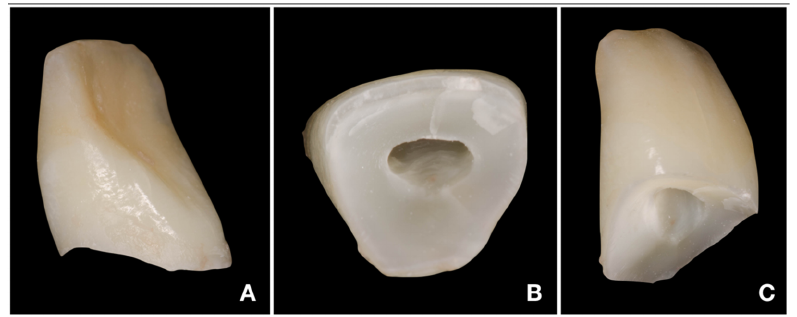
Figure 5. Partial pulpotomy and adhesive fragment reattachment of tooth 11. ( A )—clinical situation immediately after pulpotomy; ( B )—clinical situation after achieving hemostasis; ( C )—occlusal view after adhesive reattachment and removal of coronal fragment of tooth 21.